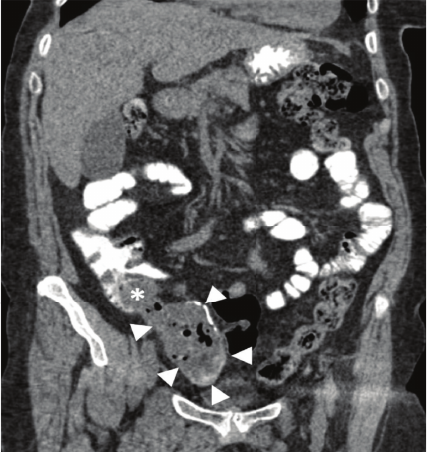
Figure 1: NECT-coronal MPR, showing the lesion (white arrow- heads) in continuity with the cecum